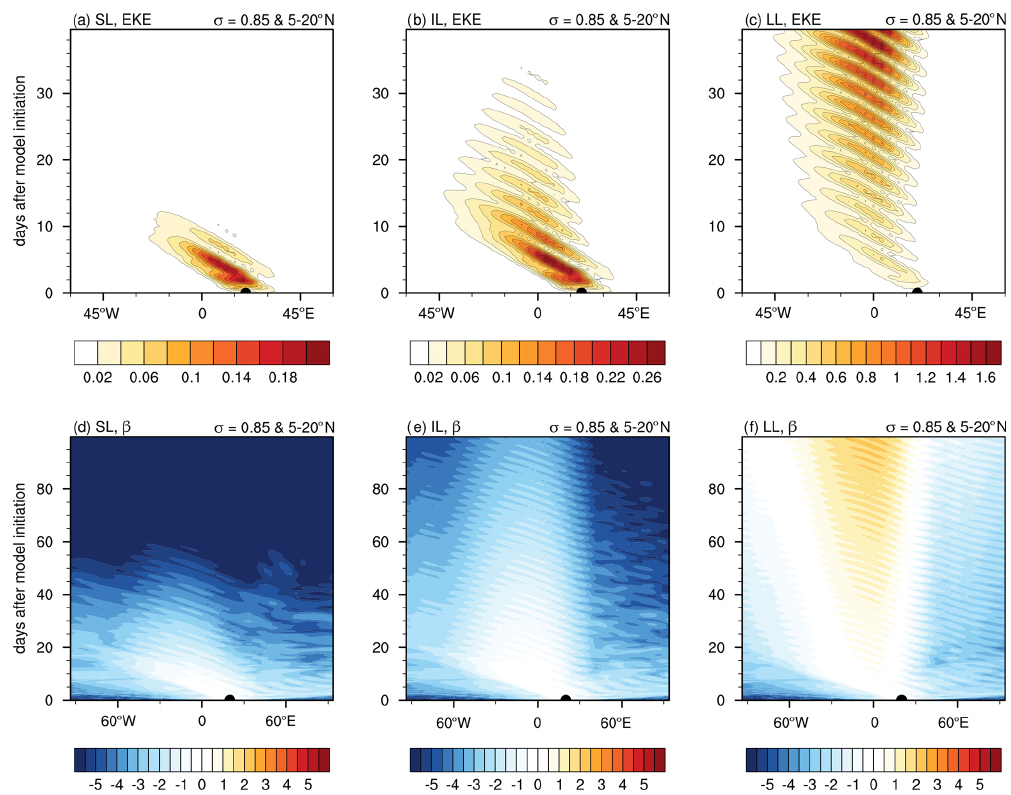
Figure 10. Hovmöller diagram of EKE (a–c) and β (d–f) at σ = 0 . 65 resulting from fixed heating on the short- (a, d) , intermediate- (b, e) , and long-lived (c, f) composite basic states averaged over 5–20 ◦ N. The black dot represents the location of the initial heating perturbation.